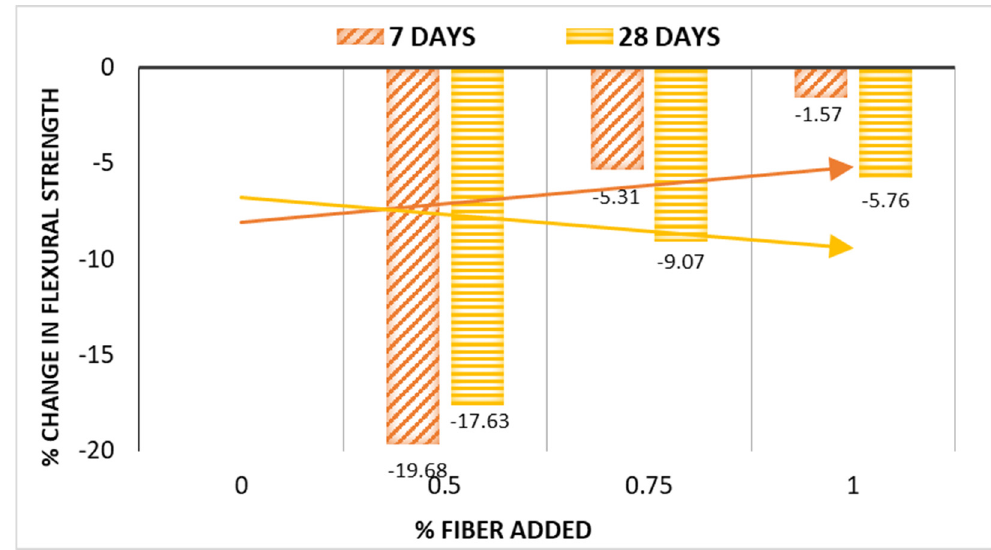
Figure 16. Percentage changes of flexural strength with varying wire percentage.